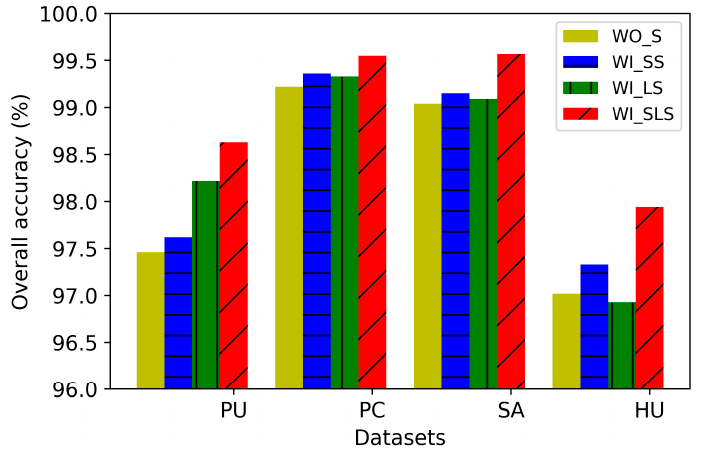
Figure 13. Effectiveness analysis of subpixel operations.